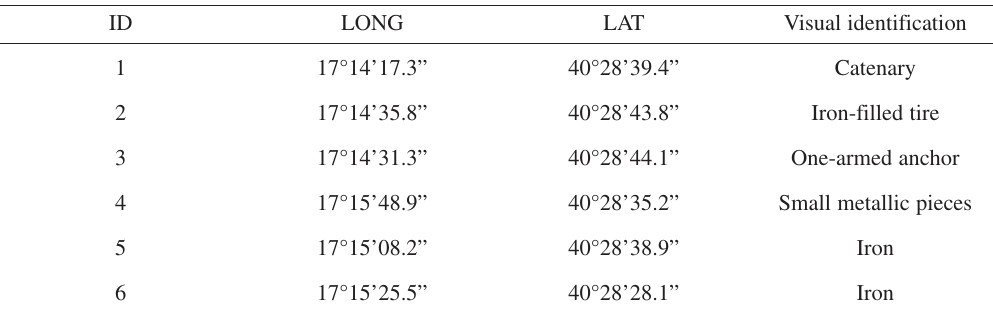
Table I. Relevant points and metallic objects identified via visual